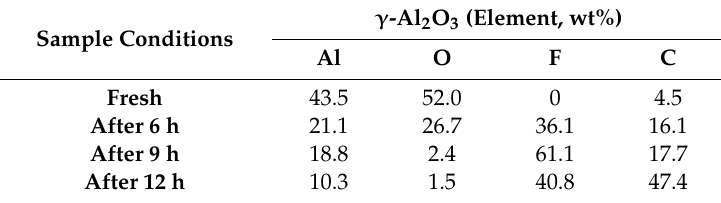
Table 2. EDS results for fresh and spent γ -Al 2 O 3 used in the single-bed reactor. Sample Conditions